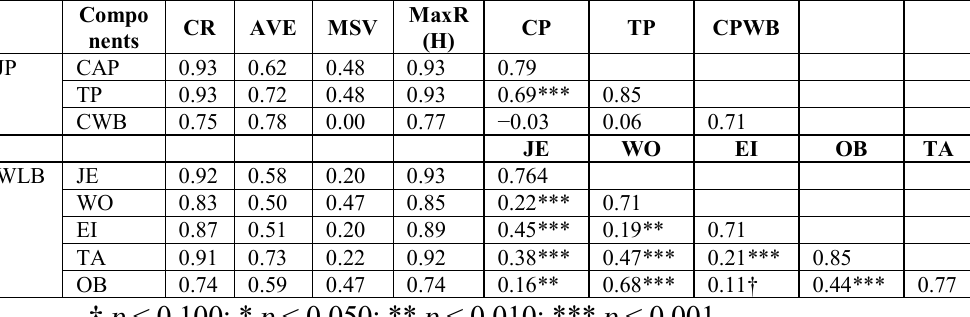
Table 3. Validity Analysis and Correlations between Constructs